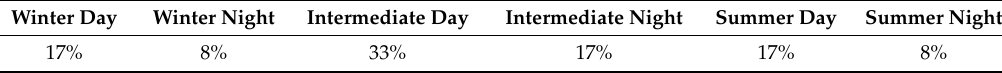
Table 2. Time disaggregation (% of one